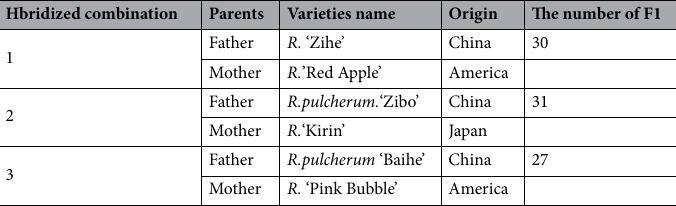
Table 8. The situation of 3 hybrid